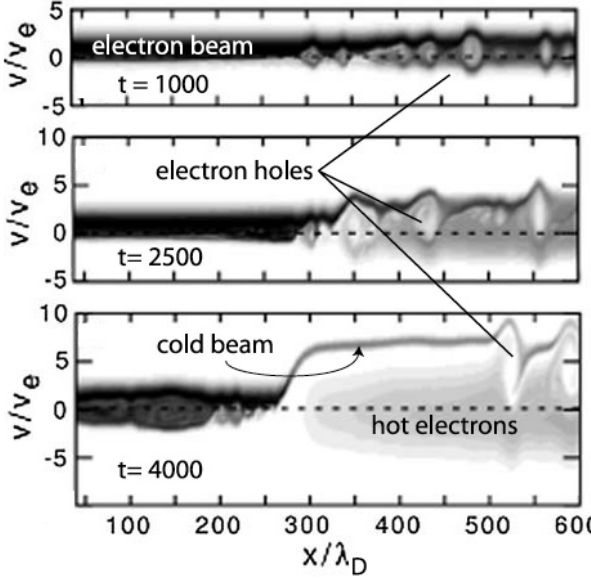
Fig. 7. The electron momentum phase space in a one-dimensional simulation of the formation of electron holes under the conditions of a Buneman unstable plasma (data compiled from Newman et al., 2002). These are three snapshots of the evolution of the electron distribution function corresponding to the direction parallel to the ambient magnetic field after start of the instability. Times are mea- sured in inverse electron plasma frequencies (electron-plasma peri- ods) ω − 1 e , spatial scales are in Debye lengths λ D . The initial elec- tron beam is warm with ion-frame drift | V e | exceeding the electron thermal speed. Ions, not shown, move in the opposite direction. At tω e = 10 3 Buneman mode evolution and propagation is seen to become localised evolving into the electron beam distribution, trap- ping and reflecting electrons out of the beam. Growing holes at time tω e = 2500 coalesce to form common structures, some struc- tures becoming very extended in velocity and configuration space at final simulation time tω e = 4000. The large hole has split the initial hot beam into a very cold beam of seven times initial veloc- ity and a very dilute hot trapped electron distribution of about ten times initial thermal spread. One should note the sharp positive ve- locity gradient between the holes and the cold beam and compare it to the weak negative velocity gradient of the hot trapped electron